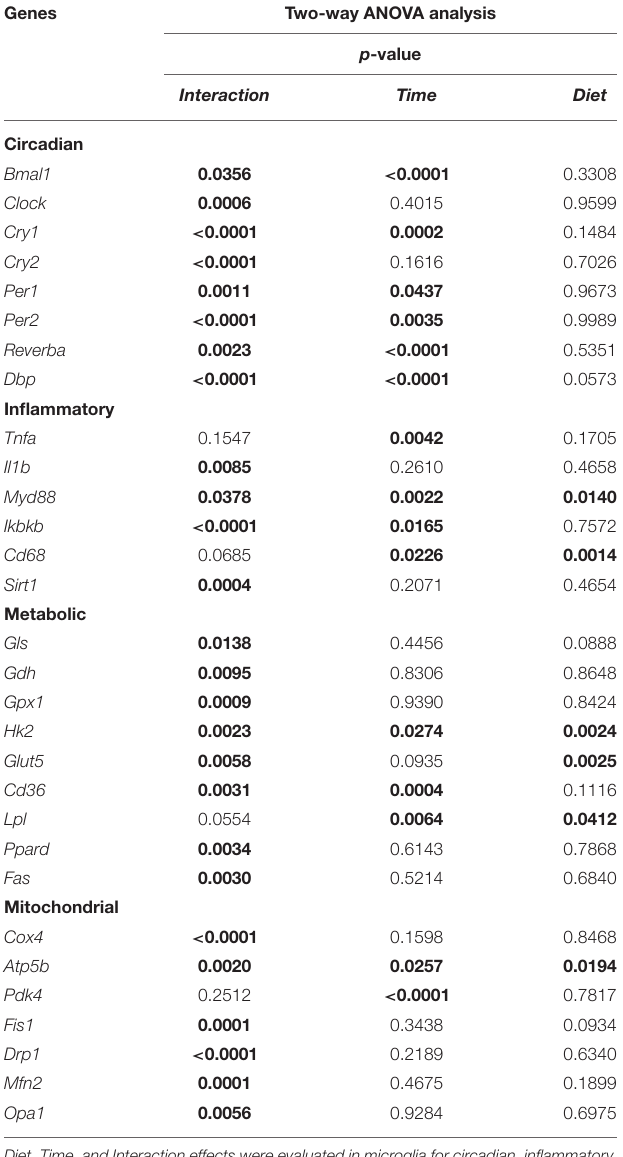
TABLE 1 | Two-way ANOVA assessment of effect of Time, Diet, and Interaction in microglia. Genes Two-way ANOVA